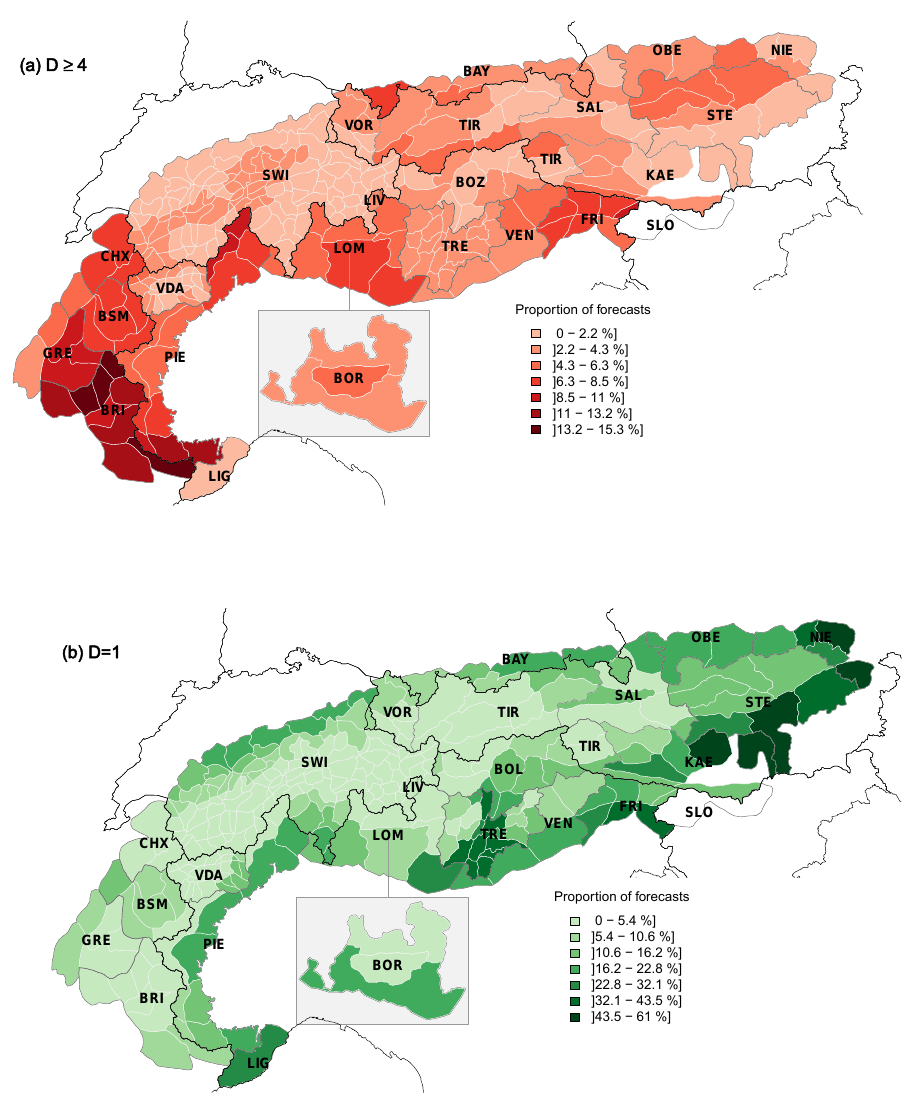
Figure 7. Map showing the European Alps with the proportion of days (a) with very critical forecast conditions ( P v . crit , D max ≥ 4) and (b) with a forecast danger level of 1 ( P favor ; D max = 1). The color shading of the individual warning regions (white borders) corresponds to the values of P v . crit and P favor , respectively. Forecast centers are labeled according to Table 2 and marked with dark gray polygon borders; national borders are marked with black lines. To visualize the (at least partially) overlapping forecast regions in the Italian region of Lombardia, LIV is superposed onto parts of LOM, while BOR is placed as an inset to the south of LOM. Thresholds for the color classes were defined using the Fisher–Jenks algorithm minimizing within-class variation (Slocum et al., 2005; R package classInt : Bivand,